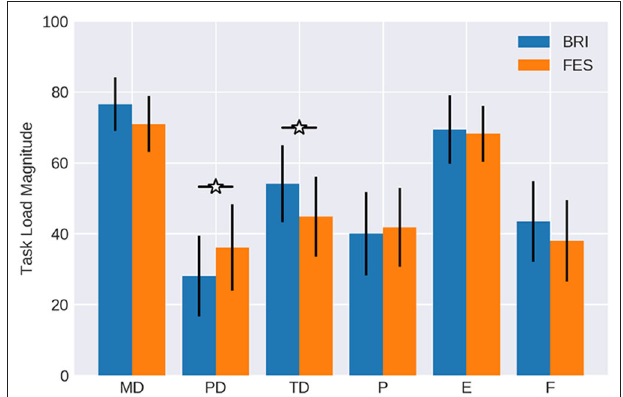
FIGURE 4 | Magnitude of workload. Subjects rated the mental demand (MD), physical demand (PD), temporal demand (TD), performance (P), effort (E) and frustration (F) of the NASA-TLX for BMI control of passive movement with different feedback modalities (Robotic vs. FES) on a scale from 0 to 100. Data is averaged over all subjects. Confidence intervals are given with a probability of 95%.